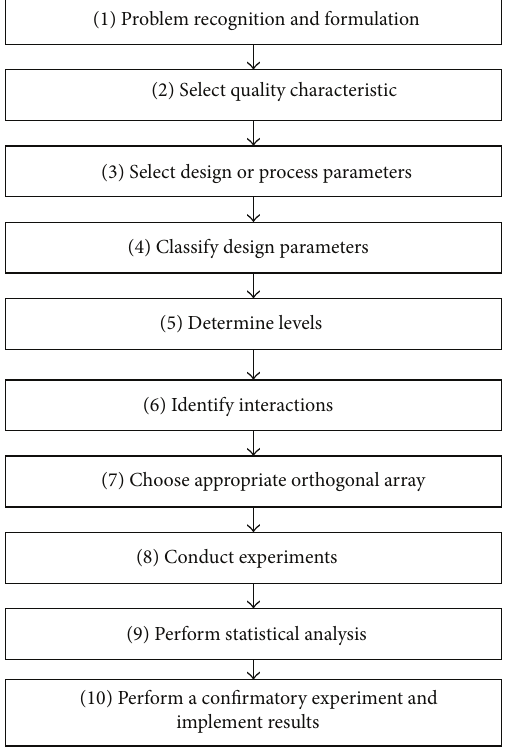
Table 3: Standard L